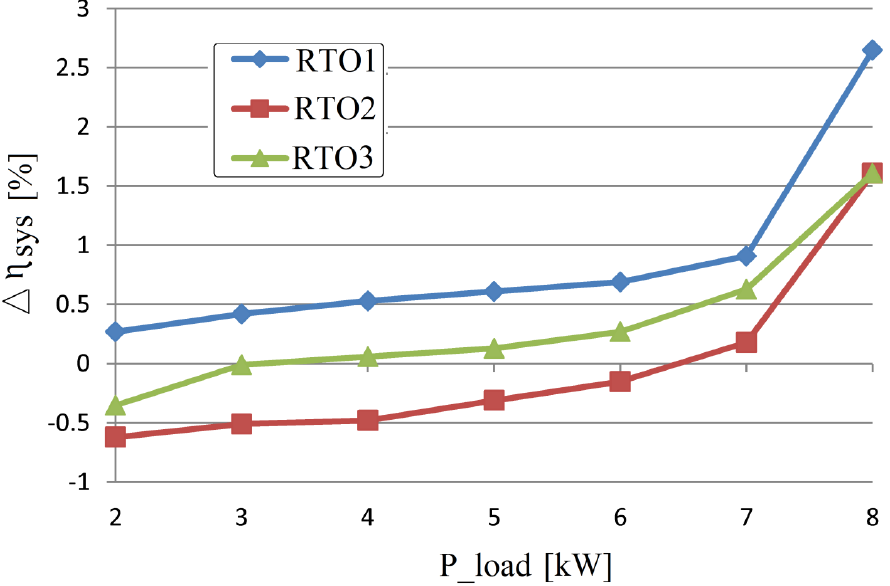
Energies 2018 , 11 , x FOR PEER REVIEW Figure 5. The gaps in FC electrical efficiency for the strategies RTO1, RTO2, and RTO3.